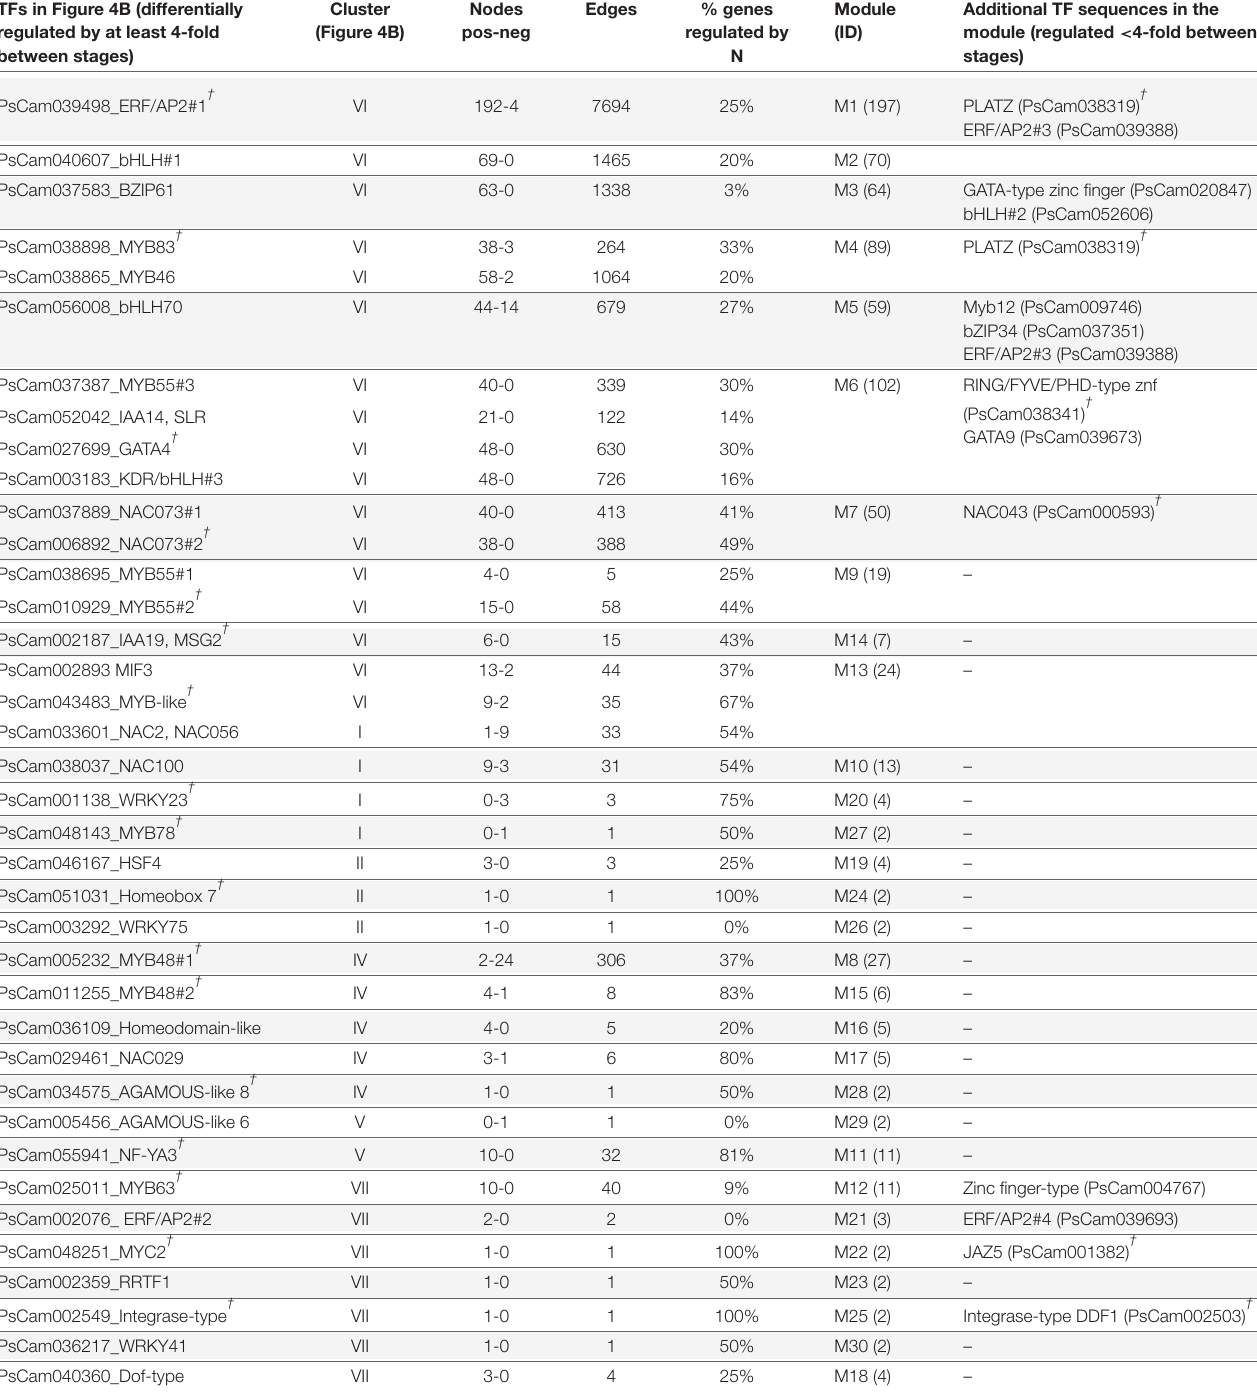
TABLE 1 | TF-related modules in the P-REMONET co-expression network. TFs in Figure 4B (differentially regulated by at least 4-fold between stages)